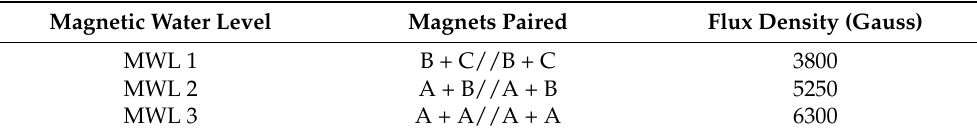
Table 2. The different flux densities produced from the different magnetic unit